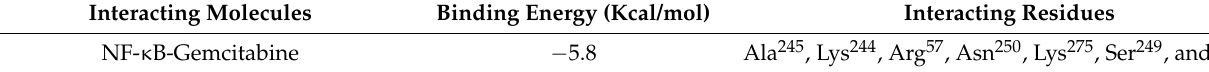
Table 1. Molecular interaction studies of 3-Methoxy carbazole and Gemcitabine with the NF- κ B precursor p105.